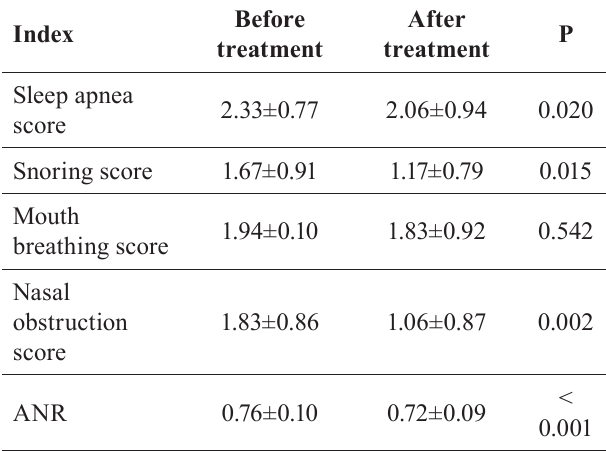
TABLE IV - Symptom scores and ANR before and after treatment in 18